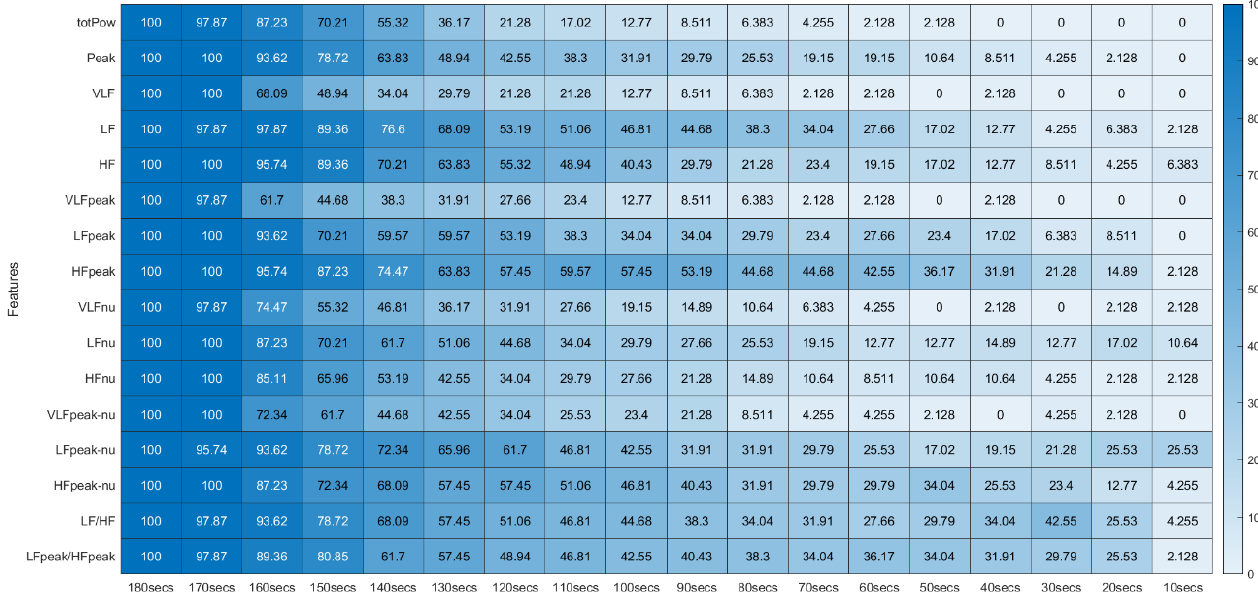
Figure 5. Wilcoxon Rank Sum Test (Time, Non-Linear and Geometrical Domain) *Percentage of runs where the feature (line) extracted with a respective window size (column) did not present significant statistical differences compared to the same feature extracted using the 180-second window.